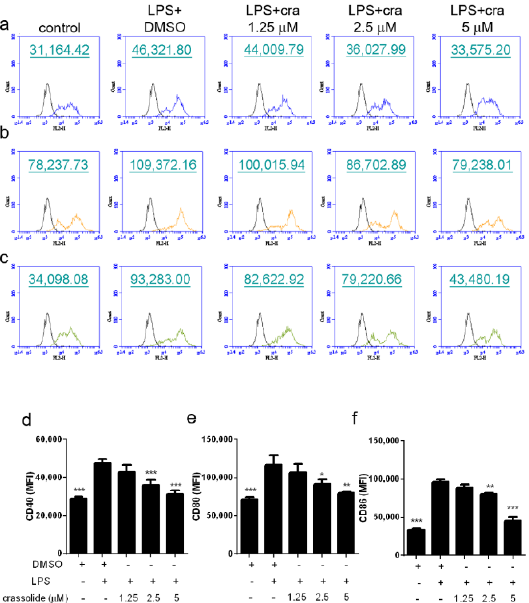
Figure 2. Effects of crassolide on lipopolysaccharides (LPS)-induced expression of surface markers in bone marrow-derived dendritic cells (BMDCs). BMDCs were treated for 2 h with either different doses of crassolide, or 0.1% DMSO followed by LPS treatment (100 ng/mL) for 24 h. ( a – c ) Expression levels of CD40 ( a ), CD80 ( b ) and CD86 ( c ) measured by flow cytometry. CD11c was used to gate live DCs. The black line represents cells labeled with isotype-matched control antibodies. ( d – f ) The relative mean fluorescence intensity (MFI) ± SEM of triplicate samples from one of three independent experiments. * p < 0.05, ** p < 0.01, *** p < 0.001, versus LPS + 0.1% DMSO-treated group, tested by one-way ANOVA followed by Tukey’s multiple comparison test.